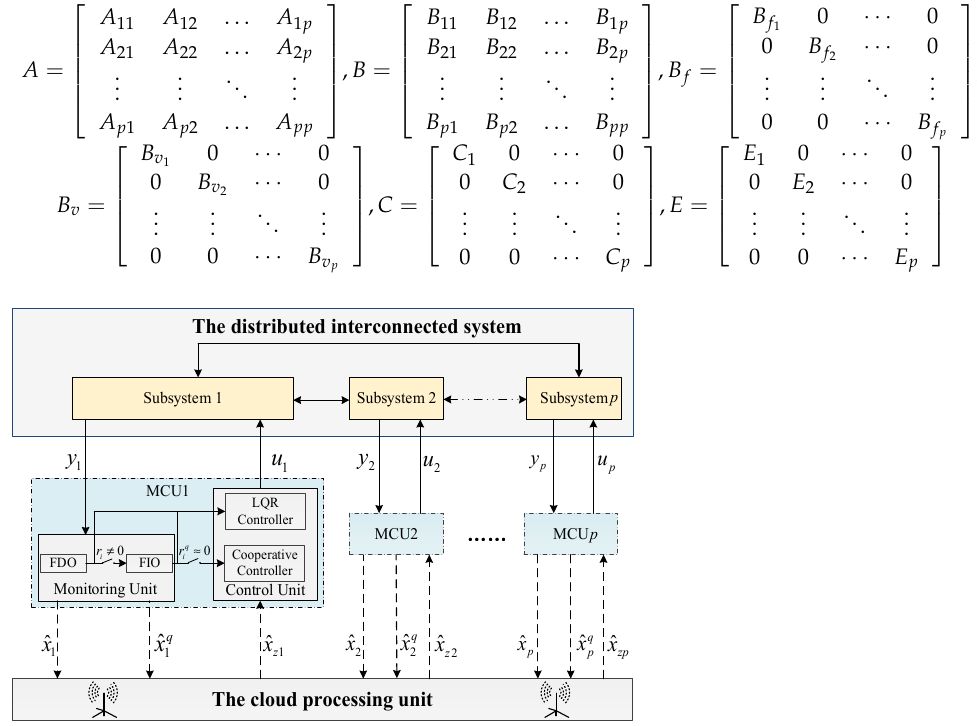
Figure 1. The distributed fault diagnosis and cooperative fault-tolerant control design framework.